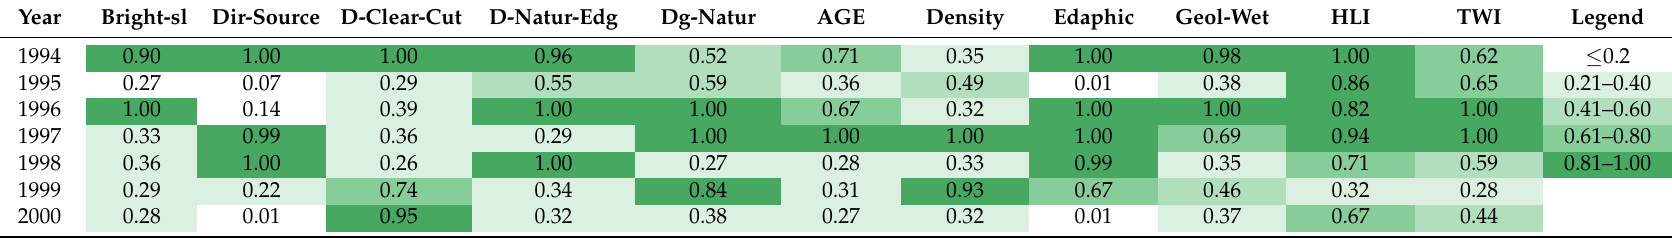
Table A2. Predictor importance weights based on multimodel inference when only the Brightness slope is used with the environmental predictors. The darkest/lightest green show the highest/lowers predictor importance